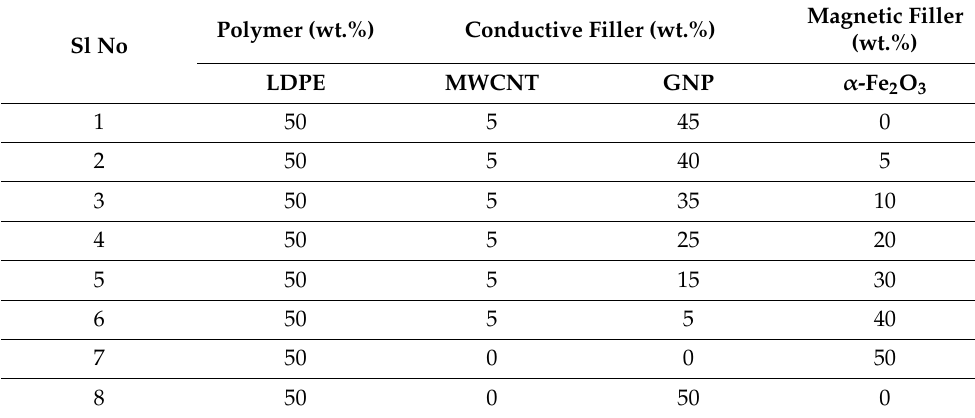
Table 1. Polymer nanocomposites combination table. Polymer (wt.%) Conductive Filler Sl No